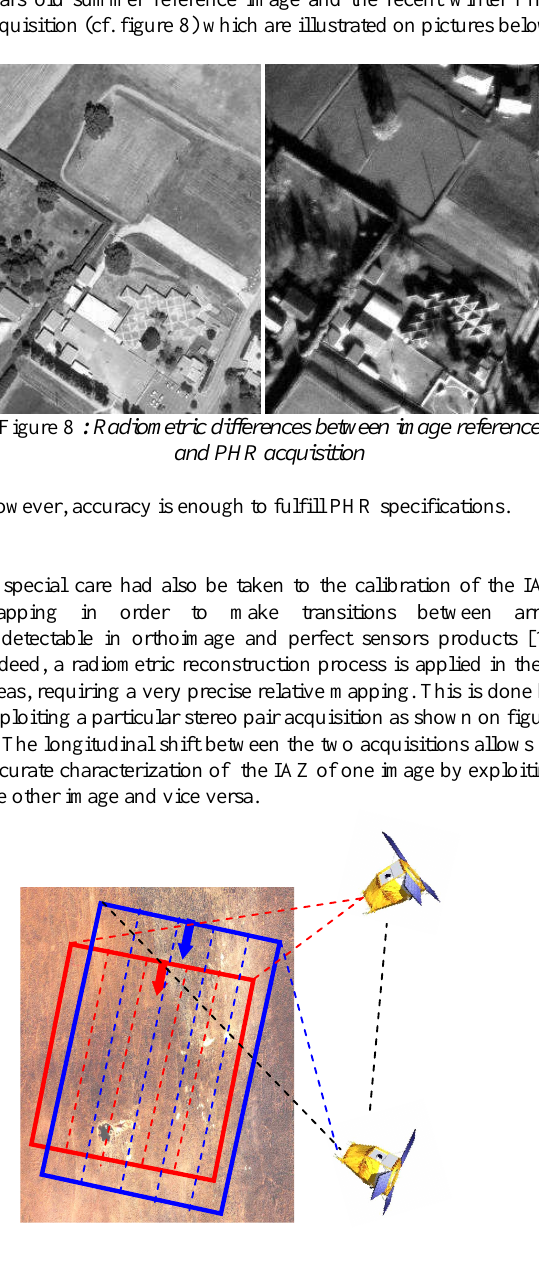
Figure 9 : IAZ calibration stereo-pair acquisition